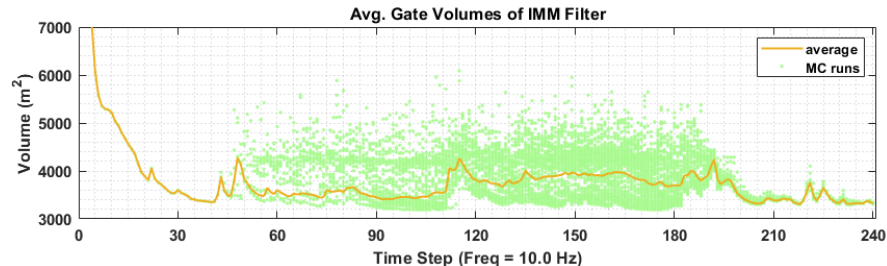
Figure 7. Average gate volume of IMM filter.